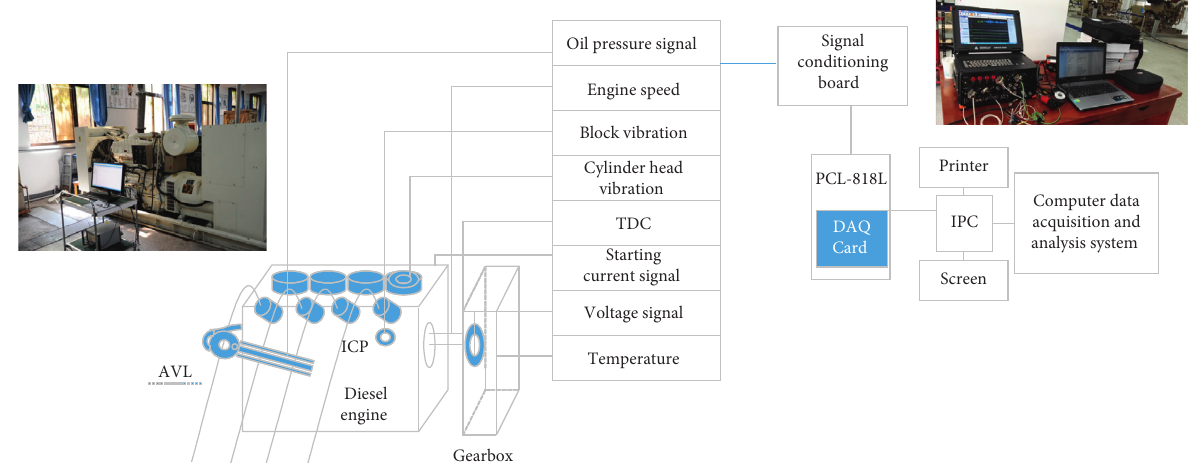
Figure 6: Experimental platform. Table 1: Parameters of value in different conditions (unit: